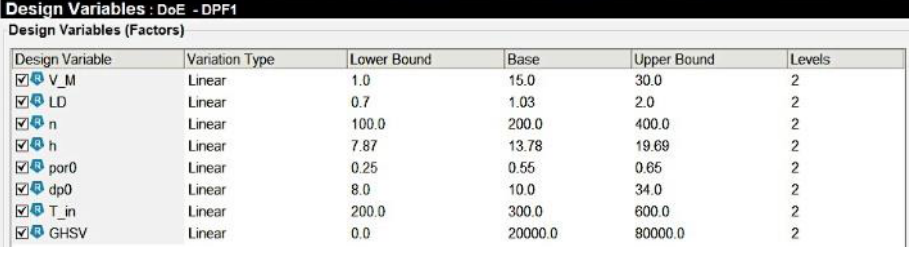
Fig. 4. Input parameters and their value ranges in DoE simulation of PD emp , ( V_M : Apparent volume of the DPF; LD : Length-to- Diameter ratio; n : Cell density; h : wall thickness; por0 : Initial porosity of the filter wall; dp0 : Initial mean pore diameter of the filter; T_in: Inlet gas temperature ( ℃ ); GHSV : Space velocity (h -1